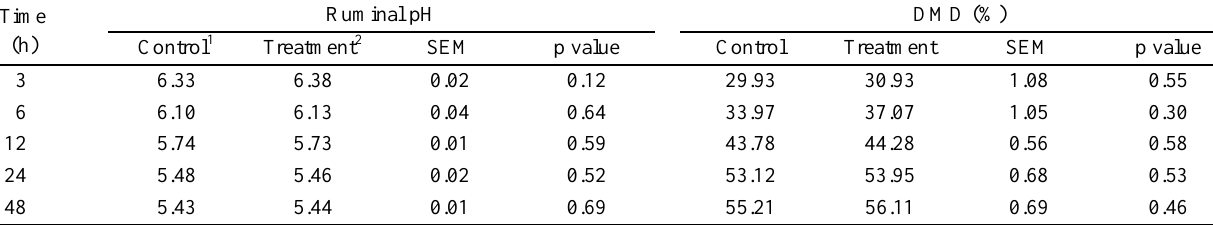
Table 2. Effects of supplementation of RPAAs and RPF on ruminal pH and DMD, in vitro